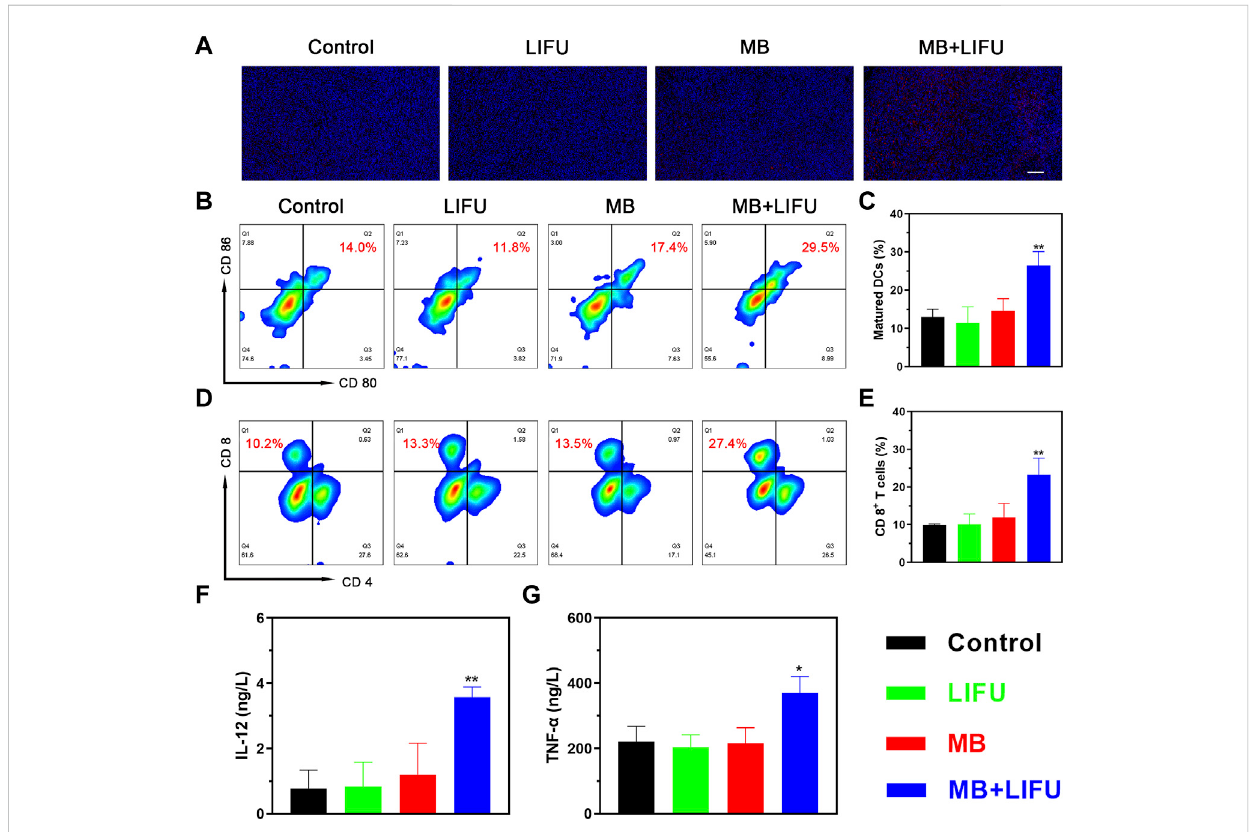
In vivo immunomodulating mechanisms. (A) Immuno fl uorescence staining of 4T1 tumors showing the induction of calreticulin (CRT) after different treatments (scale bar: 100 μ m). (B) The matured DCs (CD11c + CD80 + CD86 + ) in tumor-draining lymph nodes of mice after different treatments analyzed by fl owcytometry and (C) thecorrespondingquantitativedata. (D) Flowcytometricanalysis ofcytotoxicTlymphocytes(CTLs;CD3 + CD8 + )in4T1tumor- bearing mice and (E) the corresponding quanti fi cation of CTLs. (F, G) Cytokine levels in sera measured by ELISA assay. All data are presented